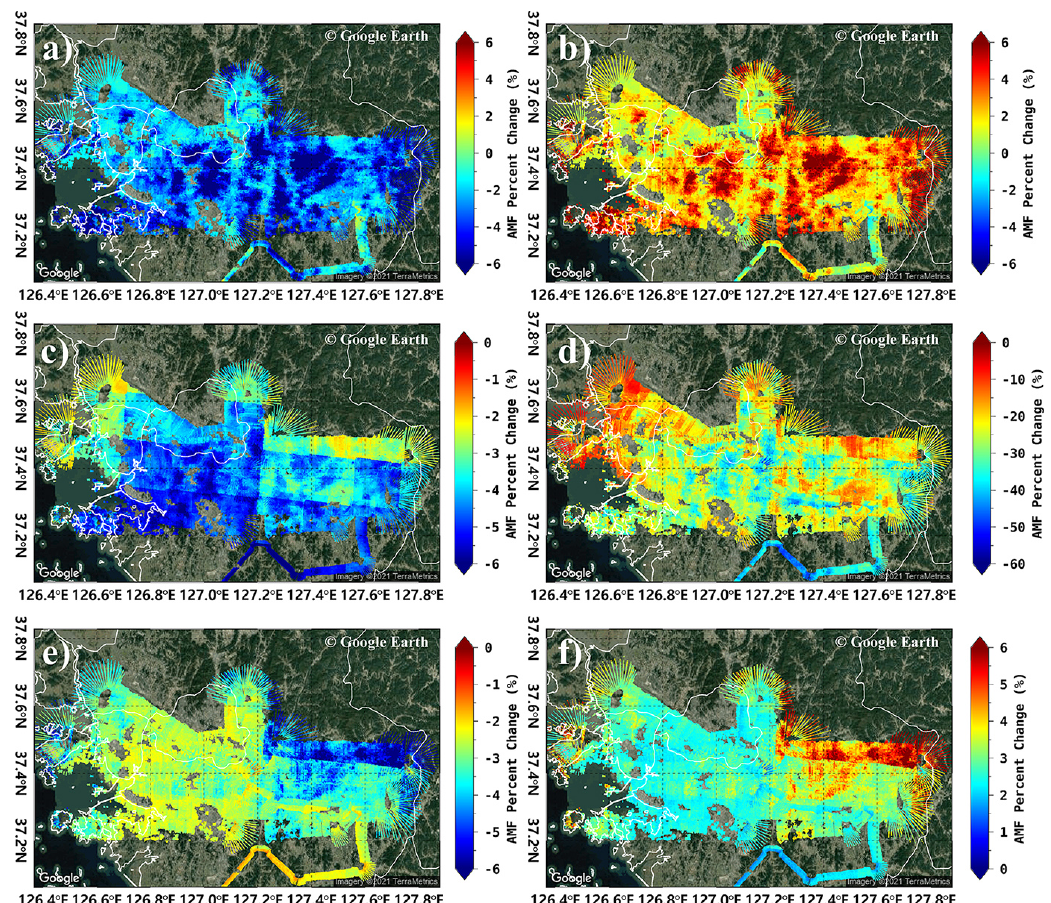
Figure 9. Percent change between AMF calculated using the CMAQ model simulation and those using (a) 30% lower AOD, (b) 30% higher AOD, (c) 0.04 lower SSA, and (d) 1km higher APH compared to the model outputs. The percentage change for AMF calculated using MODIS data and those using (e) 0 . 005 + 0 . 05 × SR lower SR and (f) 0.005 + 0.05 × SR higher SR are also shown (the background RGB image is from Google Earth; https://www.google.com/maps/, last access: 19 January